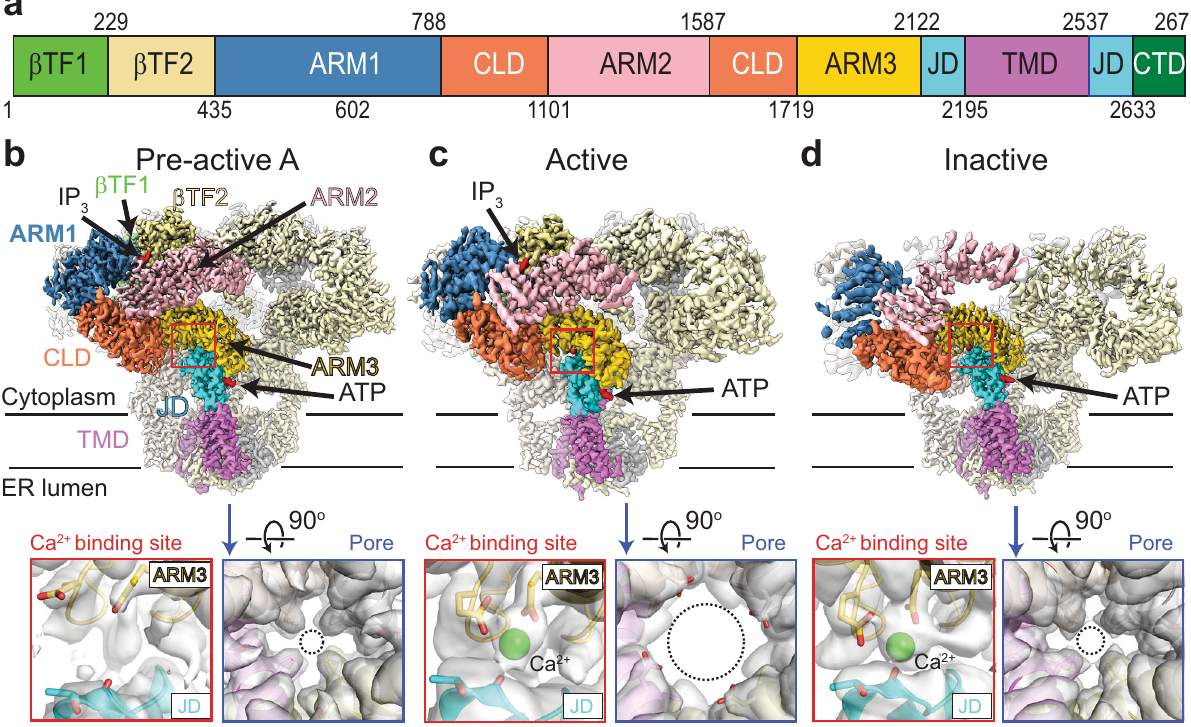
Fig. 1 Cryo-EM structures of hIP 3 R-3 in multiple conformations. a Domain boundaries of hIP 3 R-3. b – d Composite maps of hIP 3 R-3 in pre-active A ( b ), active ( c ), inactive ( d ) conformations. Each domain in one of the subunits is colored as in ( a ). Maps within the boxes, shown transparent, are close-up views of the Ca 2 + binding site (red) and the pore (blue) with ribbon representation of hIP 3 R-3. Select residues are shown in the sticks. Dashed circles indicate opening through the